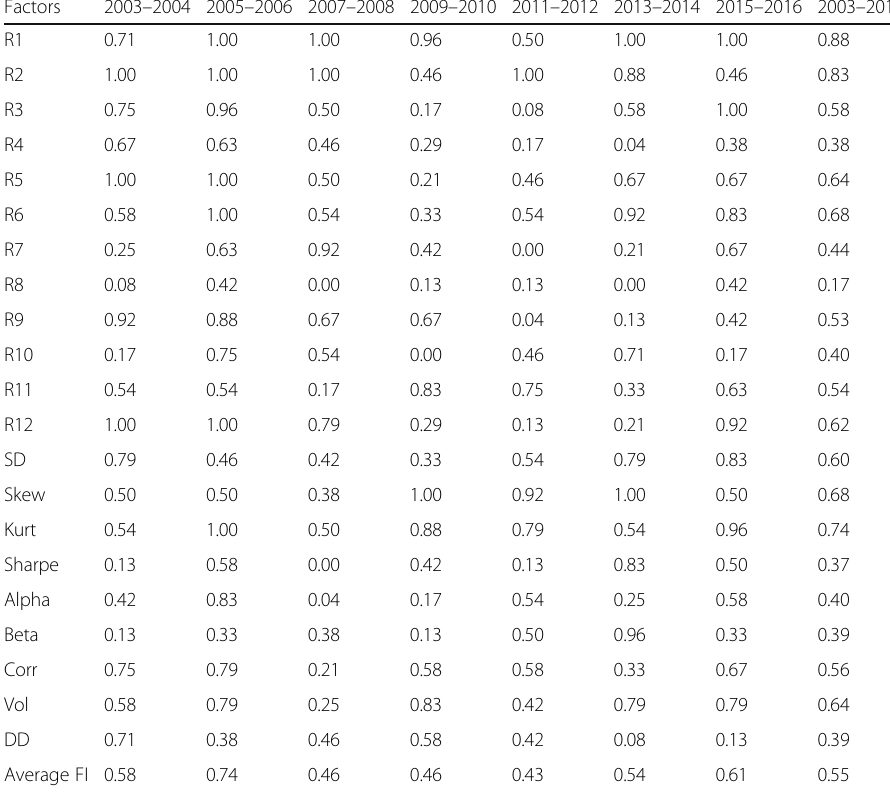
Table 6 Feature importance scores in different time periods